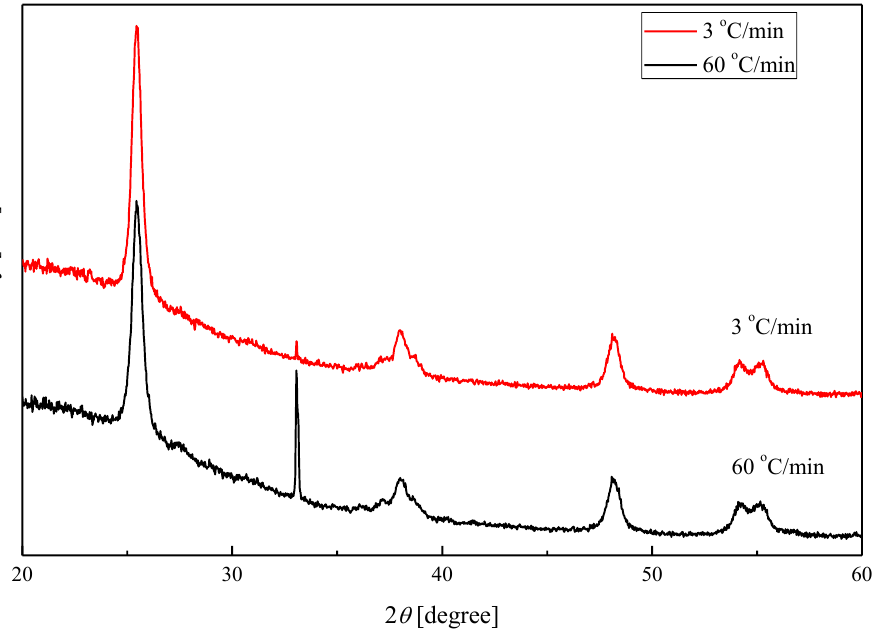
Figure 3. XRD patterns of the Ag–TiO 2 nanocomposite film annealed at 600 ◦ C with heating rates of 3 and 60 ◦ C/min. The holding time for annealing was maintained at 2 h.